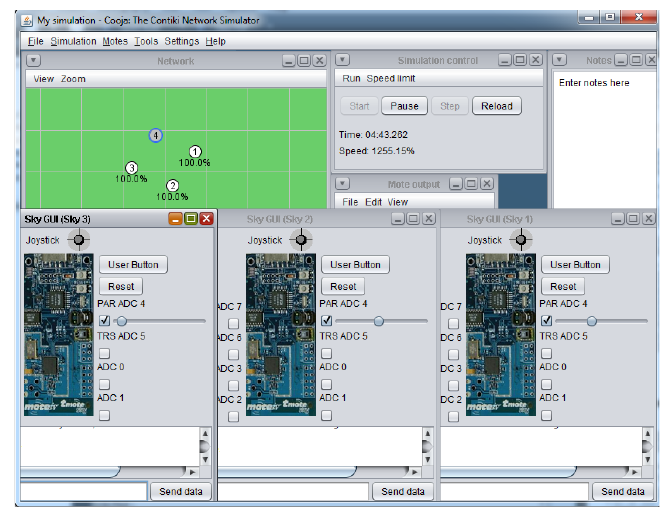
Figure 7. Advanced Sky GUI application.